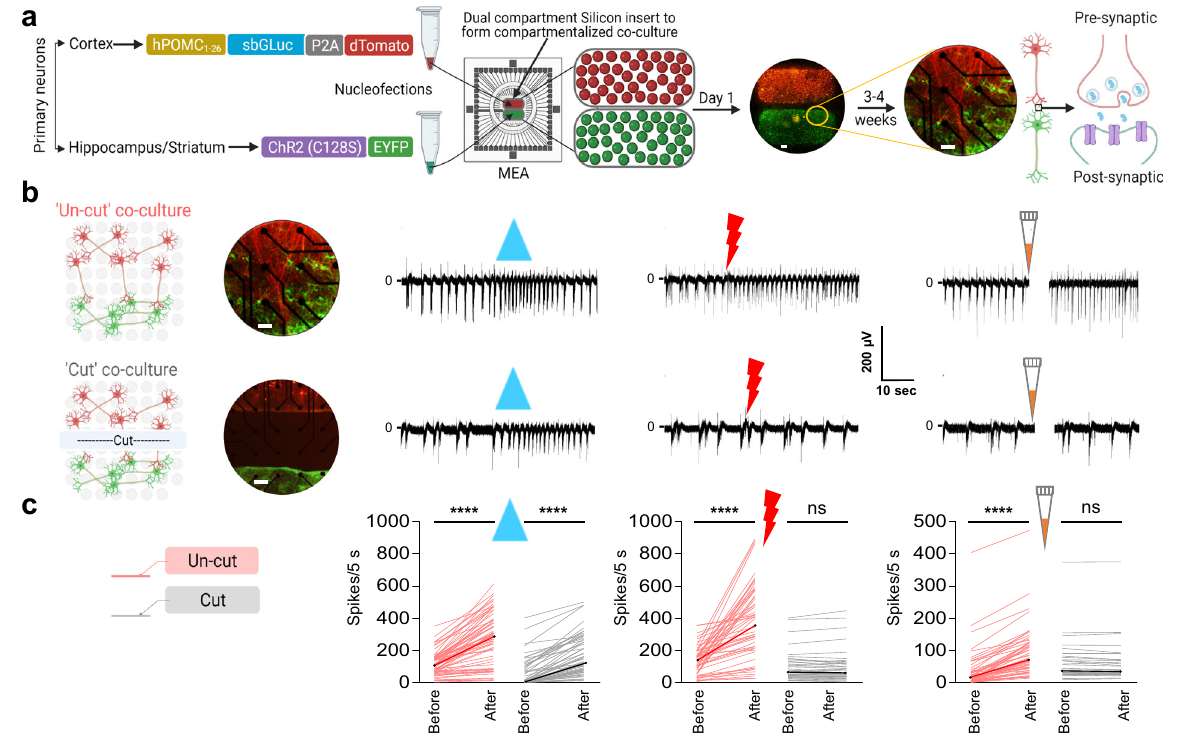
Fig. 3 Communication via Interluminescence in co-cultured populations depends on intact synaptic connections. a Schematic of experimental design and constructs used for separate nucleofections of cortical and hippocampal or striatal primary neurons. Cortical neurons were nucleofected with the luciferase construct (hPOMC1-26-sbGLuc-P2A-dTomato) and plated in the upper compartment of a 2-chamber silicon divider (group of red spheres covering the upper half of MEA electrodes), and their natural synaptic targets, hippocampal or striatal neurons, were nucleofected with the excitatory opsin construct (ChR2(C128S)-EYFP) and plated in the lower compartment (group of green spheres covering the lower half of MEA electrodes). The next day neurons had attached and the divider was removed ( fl uorescent image; ×5 magni fi cation; scale bar: 216 µ m) showing the expression of luciferase and opsin in respective neuronal populations. Cultures matured over the next 3 weeks, with processes from cortical neurons growing deep into the hippocampal or striatal areas ( fl uorescent image; ×20 magni fi cation; scale bar: 54 µ m) showing the processes from the cortical population (dTomato) contacting the hippocampal neurons (EYFP). b Illustrations showing the layout of electrodes (light gray circles) in 1-well MEAs with a co-culture (left panel) when the inter-population connections are intact (un-cut: upper left) or severed (cut: lower left) by making a cut between the two populations ( fl uorescent images; 20x magni fi cation; scale bar: 54 µ m). Recordings from one electrode within the postsynaptic population (right panels) when treated with blue light (blue solid triangle), presynaptic electrical stimulation (red bolt), and CTZ (orange pipette tip) with connecting processes intact (right upper) versus cut (right lower). c Schematic showing the color code (left panel) used for the ladder plots for both un-cut (peach) and cut (gray) co-cultures in the right panel. Ladder plots (right panel) showing change in number of spikes of postsynaptic neurons 5 s before and after each treatment (blue light; electrical stimulation; CTZ) for both the un-cut (peach) and cut (gray) conditions (blue light, un-cut n = 63, p < 0.0001, cut n = 58, p < 0.0001; electrical stimulation, un-cut n = 54, p < 0.0001, cut n = 32, p = 0.0965; CTZ, un-cut n = 51, p < 0.0001, cut n = 38, p = 0.7388; Wilcoxon matched-pairs signed rank test). The artifacts due to addition of reagents in MEAs are overlaid by a vertical white bar in all MEA recording traces (the white gap right after addition of CTZ). ns, not signi fi cant; **** p <